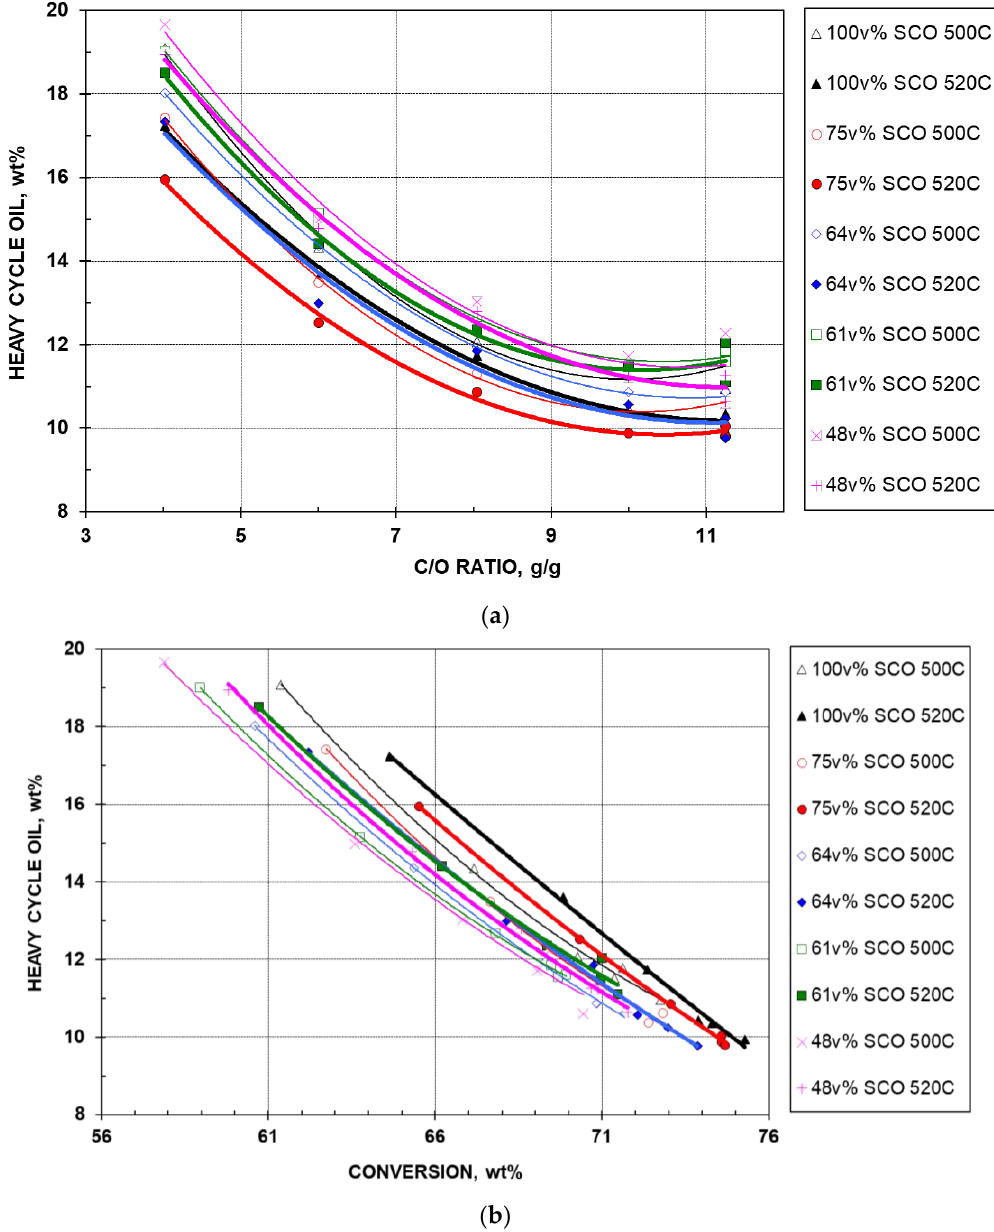
Figure 6. ( a ) HCO yield vs. C/O ratio at two reaction temperatures; ( b ) HCO yield vs. conversion at two reaction temperatures.